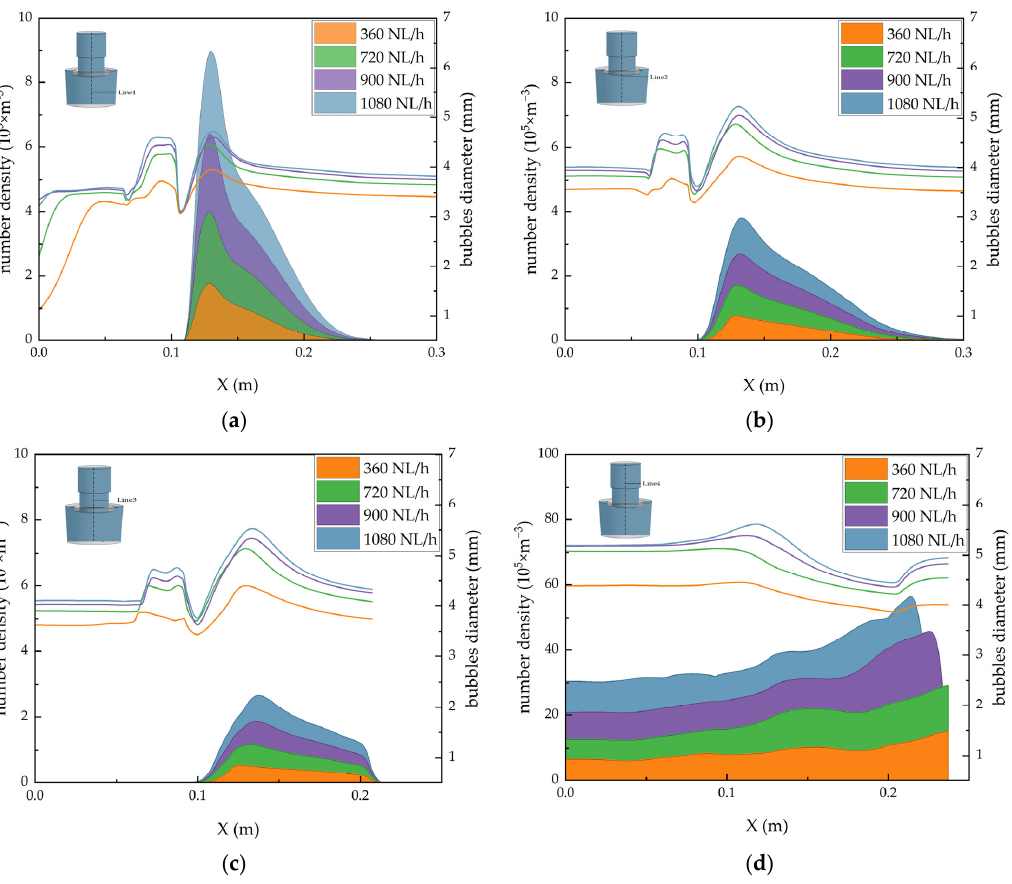
Figure 9. Distribution of the bubble diameter and number density on different lines: ( a ) Line 1; ( b ) Line 2; ( c ) Line 3; ( d ) Line 4.